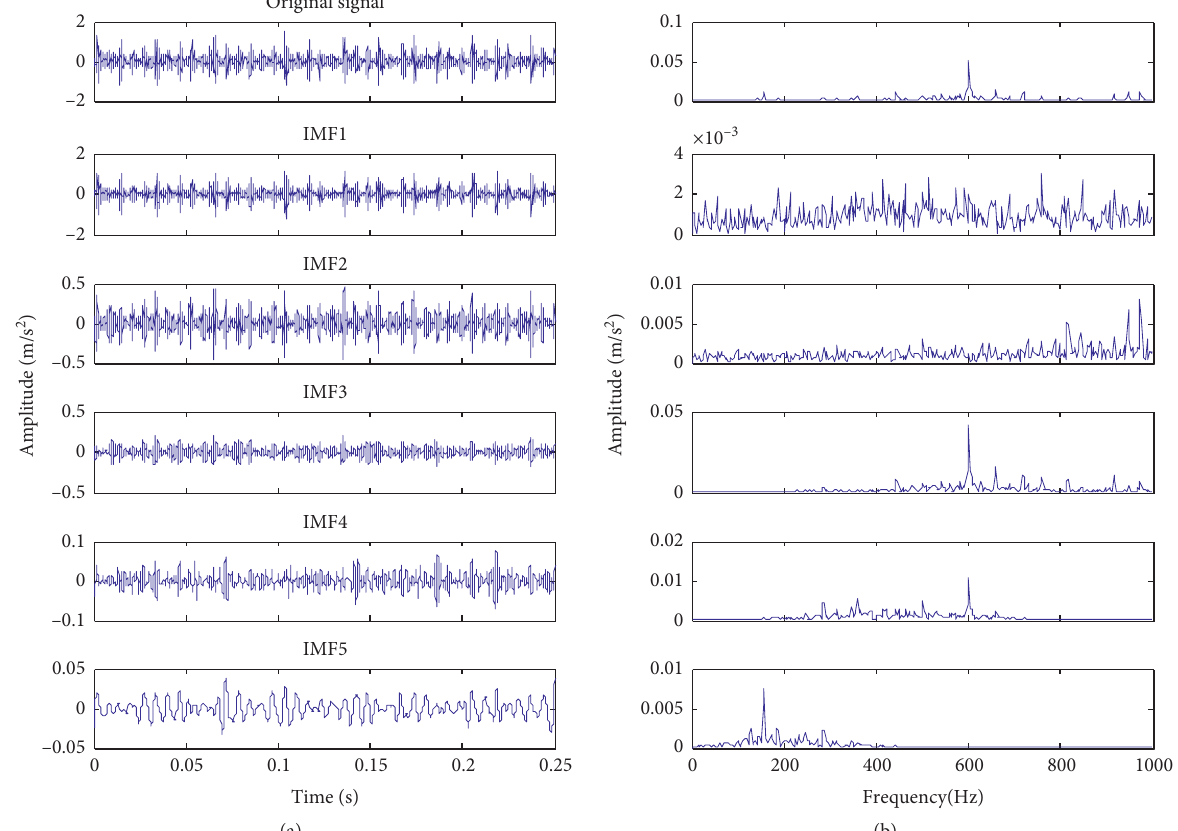
Figure 5: Decomposition results of one inner race fault signal and the FFT amplitude